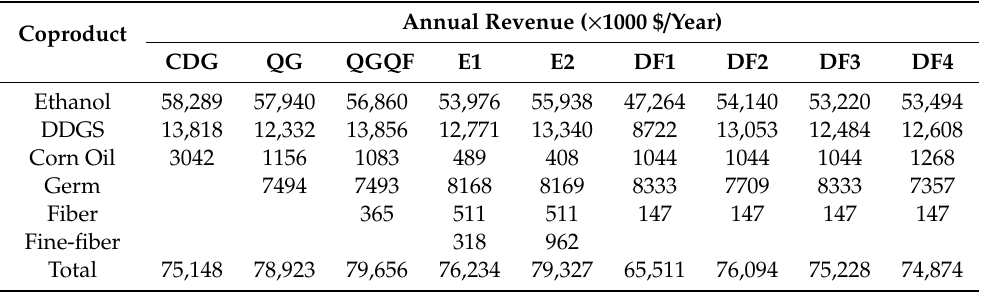
Table 5. Summary of revenue generation in conventional and modified dry grind